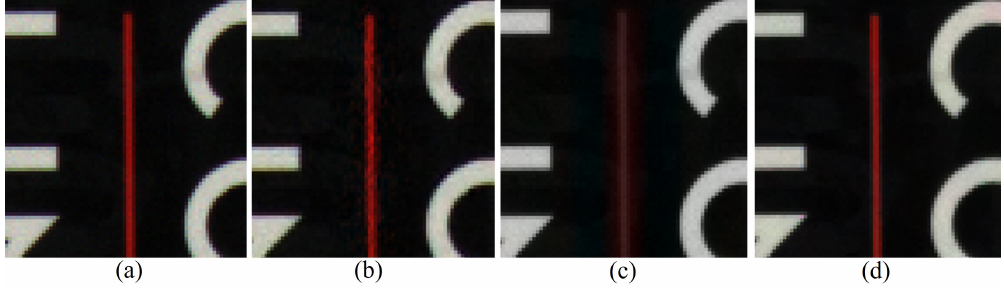
Figure 2. Effect of the rank minimization-based global interpolation with a colorization constraint, as described in (9). Experimental results on a photo image of a book. ( a ) Original; ( b ) Reconstructed using residual interpolation [14]; ( c ) Reconstructed by (7); ( d ) Reconstructed by